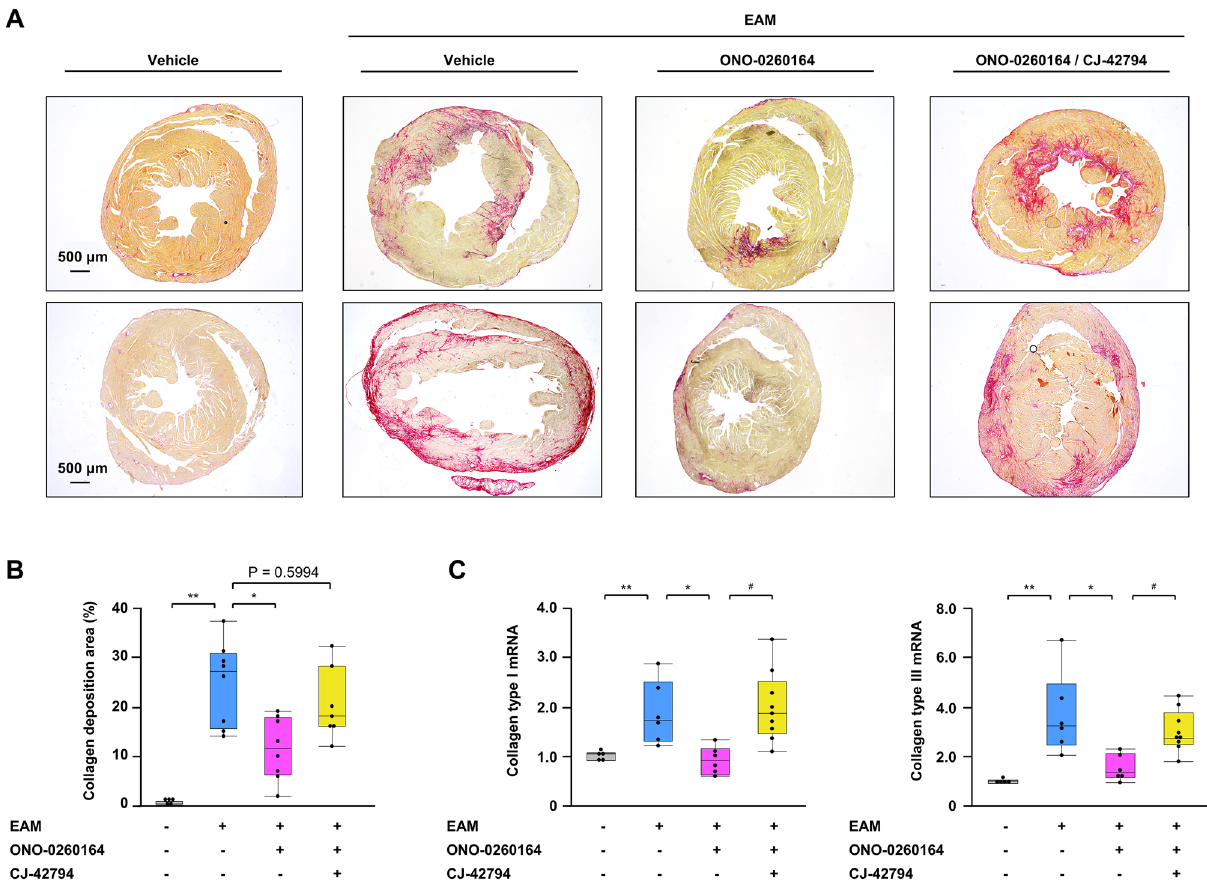
Figure 2. Myocardial collagen deposition in the experimental autoimmune myocarditis (EAM) mice. ( A ) Representative picrosirius red staining and ( B ) statistical analyses of collagen deposition area in ventricular cross-sections on day 56 obtained from non-EAM mice treated daily with vehicle (n = 5) or from EAM mice treated daily with vehicle (n = 8), selective prostaglandin E2 receptor 4 (EP4) agonist (ONO-0260164) (n = 8), or both ONO-0260164 and selective EP4 antagonist (CJ-42794) (n = 7) starting on day 14. Scale bars: 500 μm. Collagen deposition area was calculated by affected area/ventricular area × 100%. ( C ) Reverse transcription- quantitative PCR for gene expression of collagen type I and type III in bulk heart tissues on day 56 obtained from non-EAM mice (n = 5) or from EAM mice treated daily with vehicle (n = 6), ONO-0260164 (n = 6), or both CJ-42794 and ONO-0260164 (n = 9). * P < 0.05 (vs. vehicle alone-treated EAM) or ** P < 0.05 (vs. non-EAM) or # P < 0.05 (vs. both CJ-42794 and ONO-0260164-treated EAM) calculated with 2-way ANOVA followed by the Bonferroni-Dunn post hoc testing